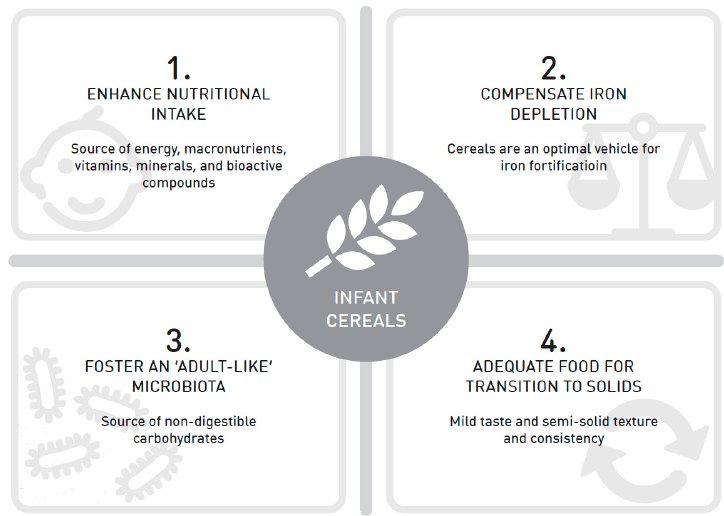
Figure 1. Four reasons to provide infant cereals as one of the first foods during the complementary feeding